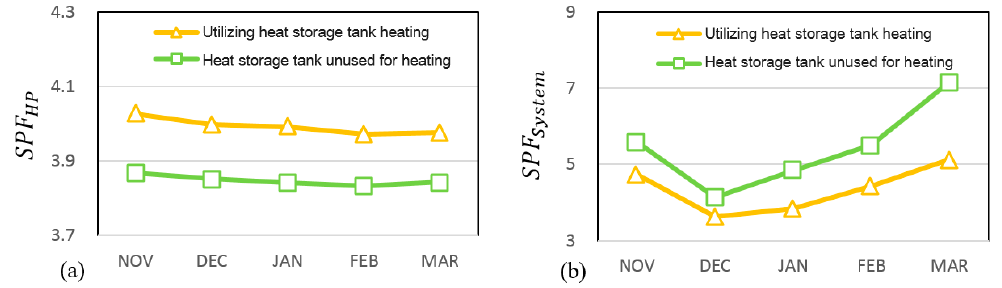
Figure 28. The SPF considering storage tank heating during daytime operation. ( a ) Heat pump; ( b ) total system. Energies 2017 , 10 , 1243